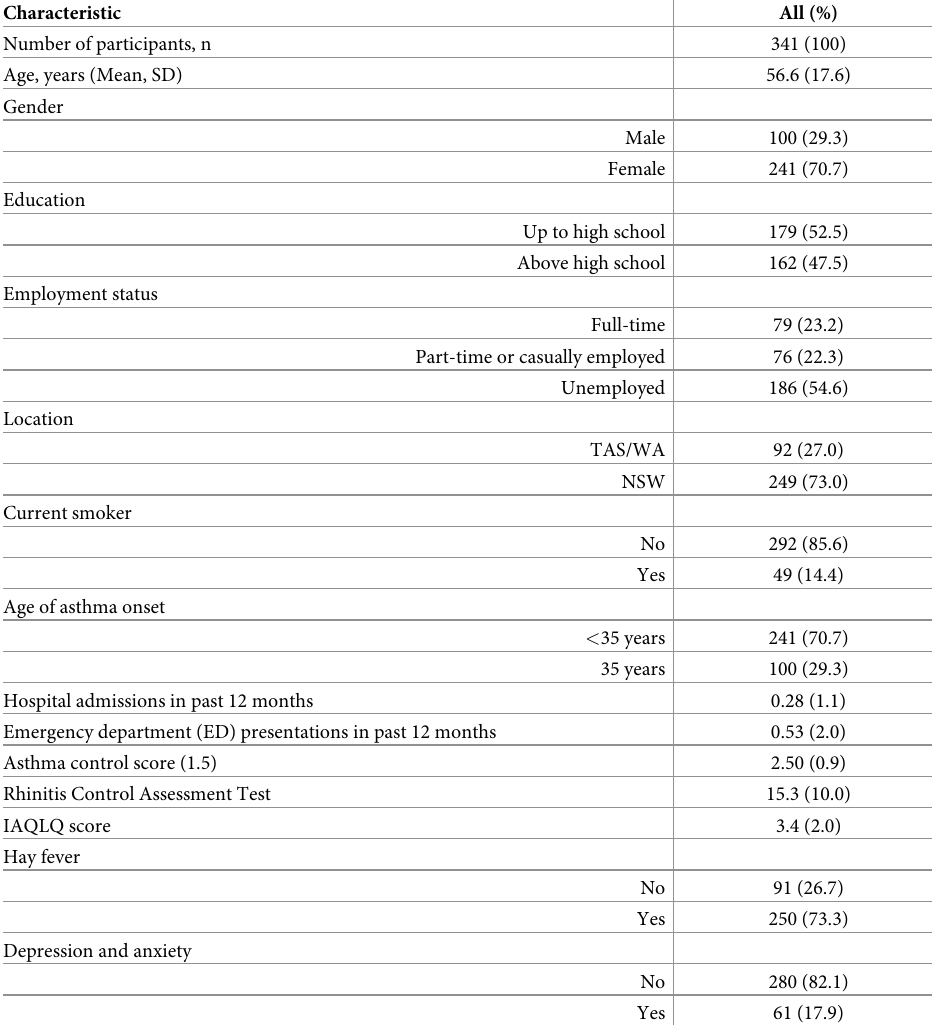
Table 1. Baseline demographic and clinical characteristics of study